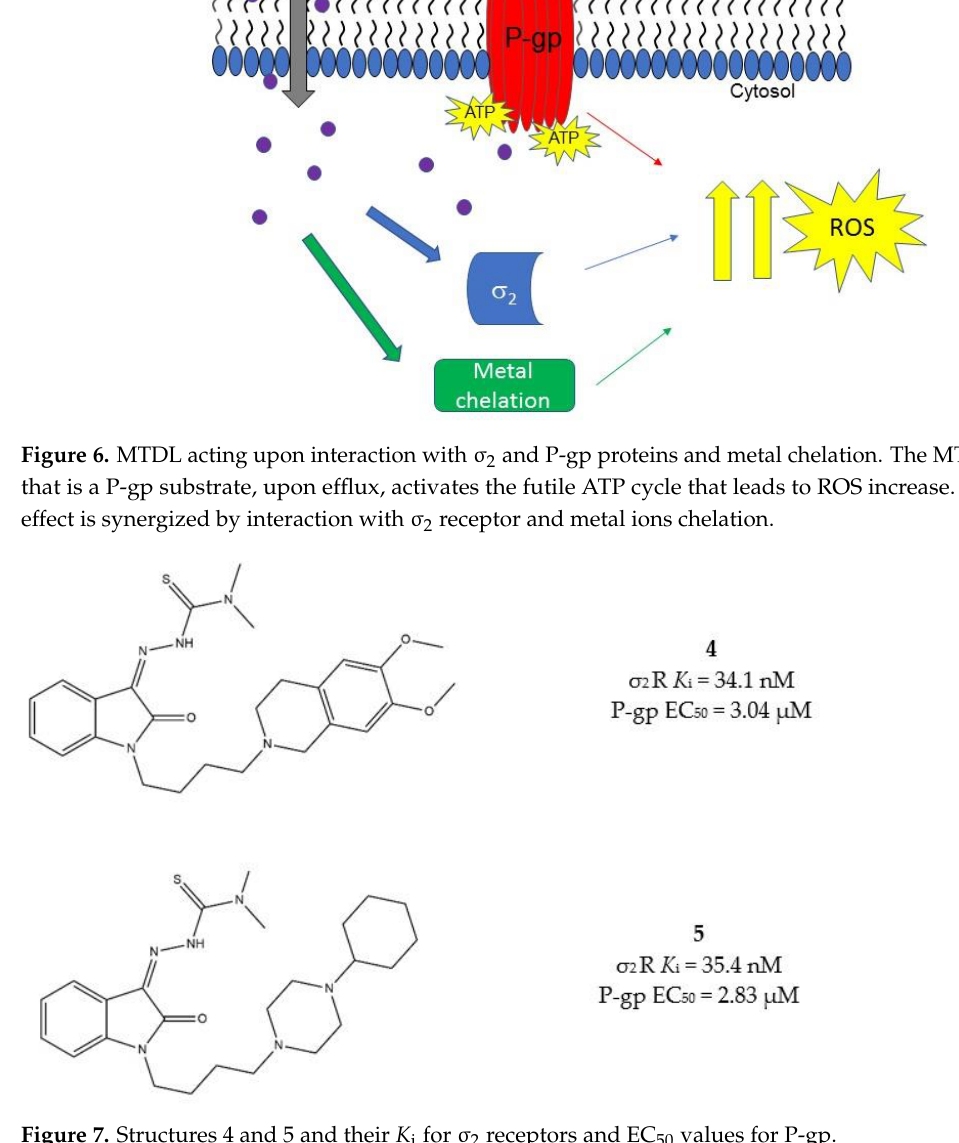
Figure 6. MTDL acting upon interaction with σ 2 and P-gp proteins and metal chelation. The MTDL, that is a P-gp substrate, upon efflux, activates the futile ATP cycle that leads to ROS increase. The effect is synergized by interaction with σ 2 receptor and metal ions chelation.